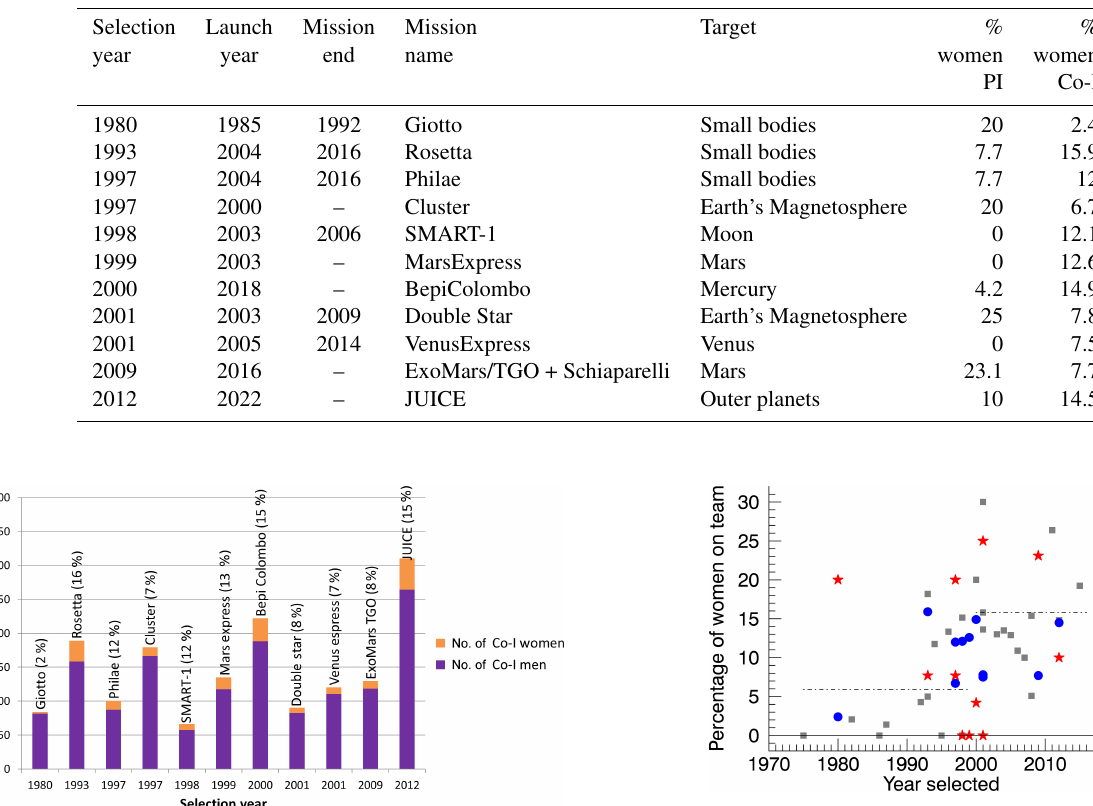
Table 1. List of ESA’s Solar System missions, ordered by year of selection. The target of the mission and the percentage of women PI and Co-I for each mission at the time when the mission was selected is indicated.